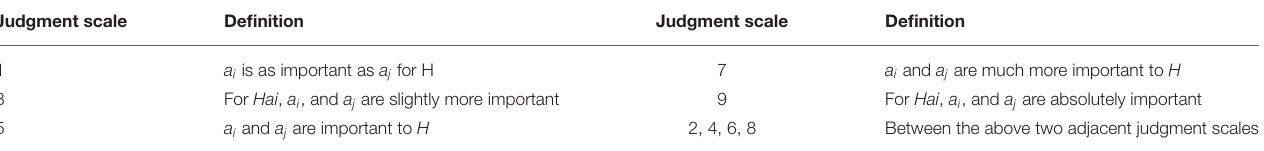
TABLE 3 | The judgment standard